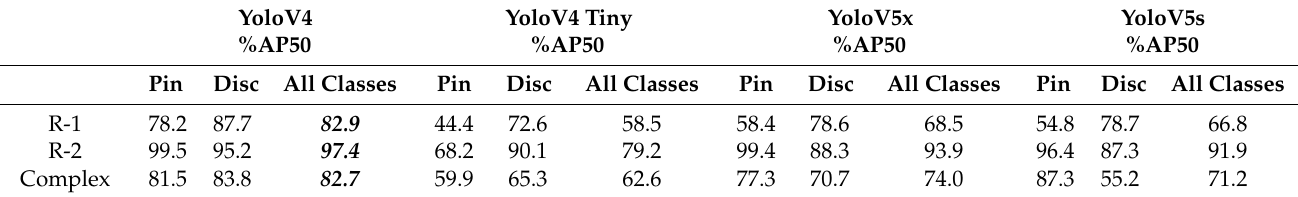
Table 4. Performance comparison of YoloV4 with other object detection models.